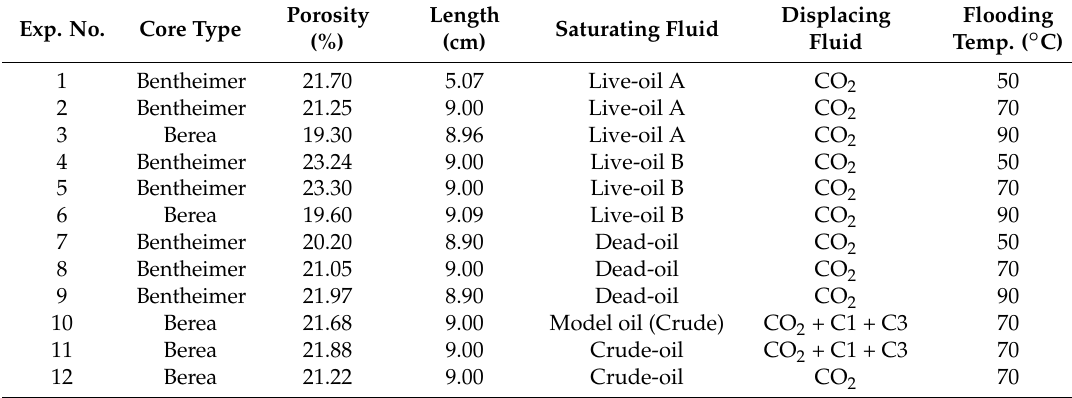
Table 1. Characteristics of cores along with associated fluid and flooding conditions.